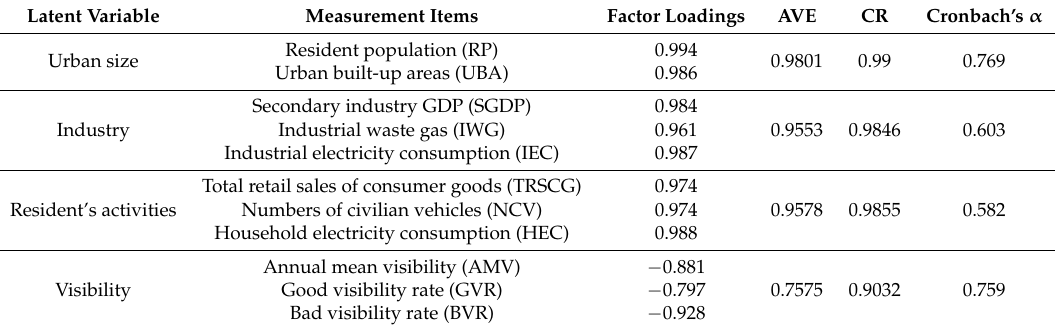
Table 5. Comparison of fitting results among models. AIC—Akaike information criterion;